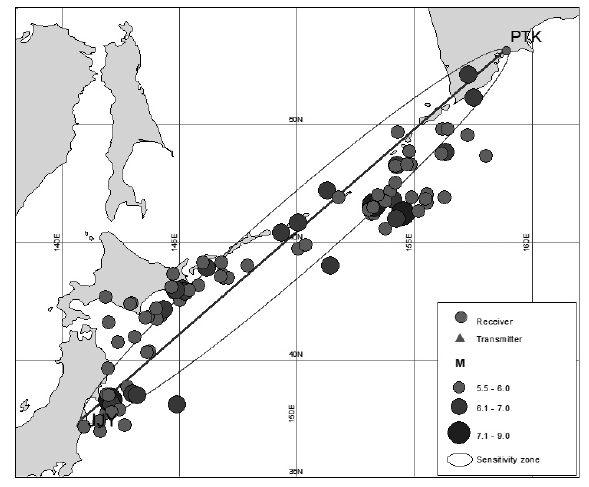
Figure 2. Map showing the position of the receiver Petropavlovsk- Kamchatsky (PTK) and transmitter JJY (40 kHz). Solid circles, posi- tions of the earthquake epicenters with M ≥ 5.5, D ≤ 150 km and R/D ≥ 0.7 for the period 2004-2007 (from USGS/NEIC http://neic. usgs.gov/neis/epic/epic_global.html); ellipse, projection of the fifth Fresnel sensitivity zone on the Earth